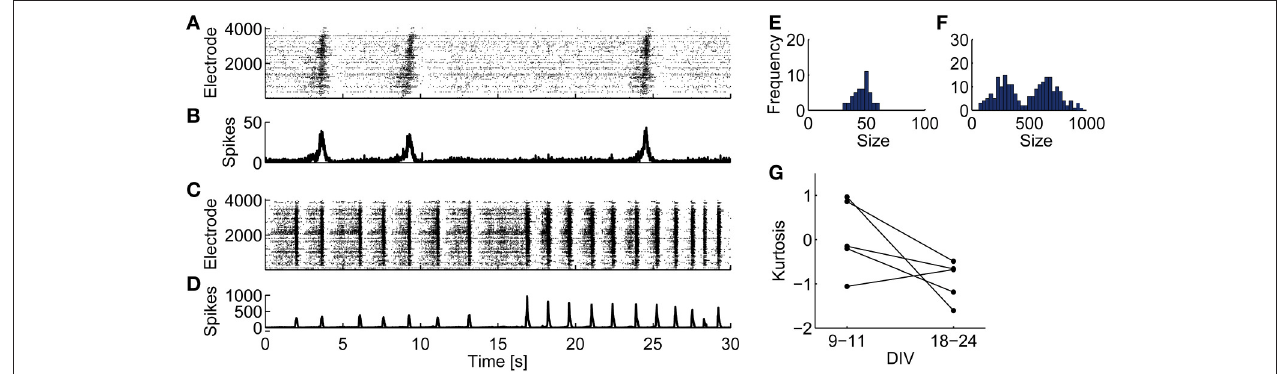
FIGURE 1 | Spontaneous spiking activities of cultured cortical neurons recorded on CMOS MEAs and distributions of burst peak amplitude. (A,B) A representative raster plot (A) and the number of array-wide spikes (B) from 30s of spontaneous activity recorded from a culture at 10DIV. (C,D) A raster plot (C) and the number of array-wide spikes (D) from recorded data from a culture at 18DIV. (E) Histogram of burst peak amplitude (the maximum number of array-wide spikes in 10-ms bins during synchronized bursts) from the same recorded data shown in (A,B) . (F) Histogram of burst peak amplitude from the same recorded data shown in (C,D) . (G) Kurtosis of the burst-peak-amplitude distribution from spontaneous activities at 9–11DIV and those at 18–24DIV.